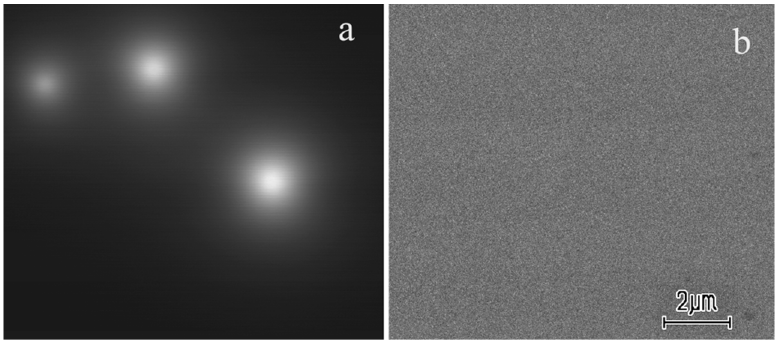
Figure 6. The EBIC image of conductive paths with different brightness made at E b = 10 keV ( a ) and the SE image of the same region ( b ).